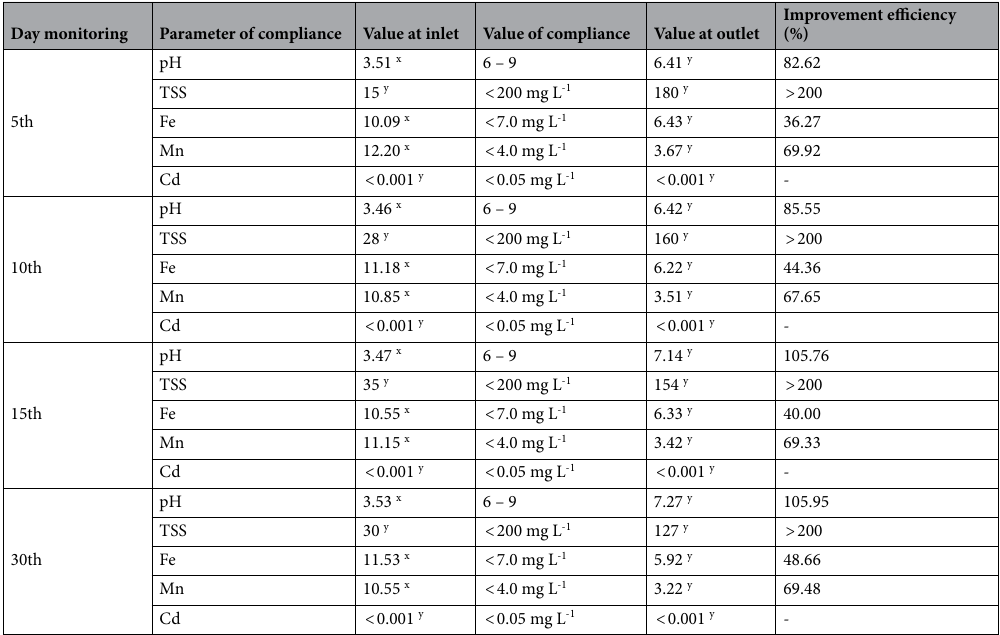
Table 4. Data of the compliance parameter of the threshold on the inlet compared with the outlet. Note: x = is not comply and y = is comply with